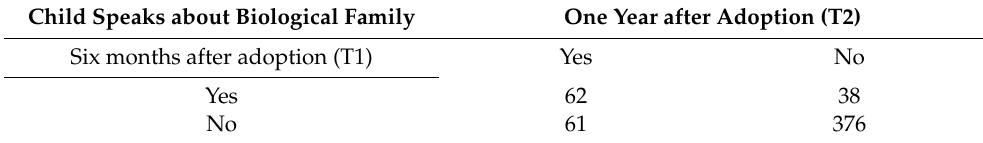
Table 3. Child’s speaks about the biological family: A comparison between the two time points. Child Speaks about Biological Family One Year after Adoption